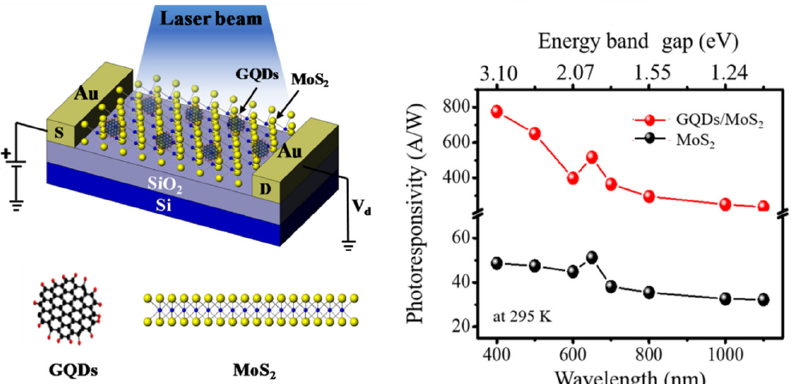
Figure 12. Schematic of the GQD/MoS 2 hybrid device under optical illumination ( left ). The insets show the corresponding molecular structures of GQD (top view) and MoS 2 (side view). Photosensitivity of hybrid GQD/MoS 2 (red) and bare MoS 2 devices (black) versus wavelength at fixed V ds = 10 V with laser wavelength varying from 400 to 1100 nm at room temperature ( right ) [31].